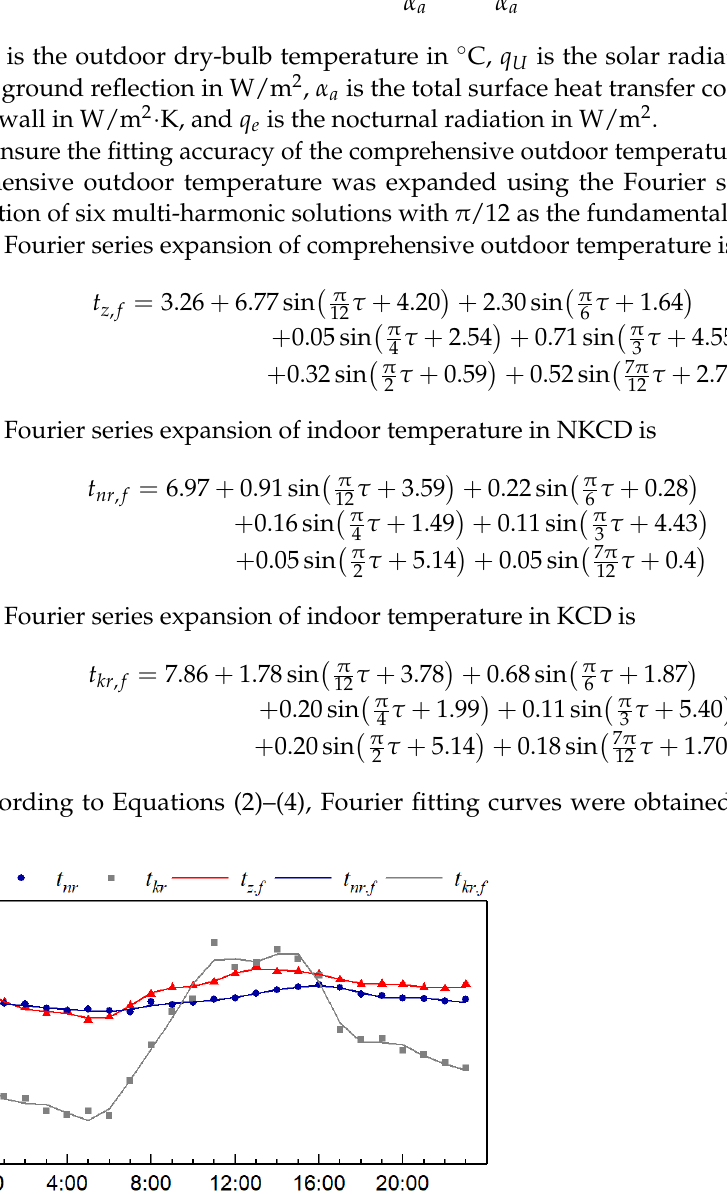
Figure 9. Attenuation of the thermal waves.